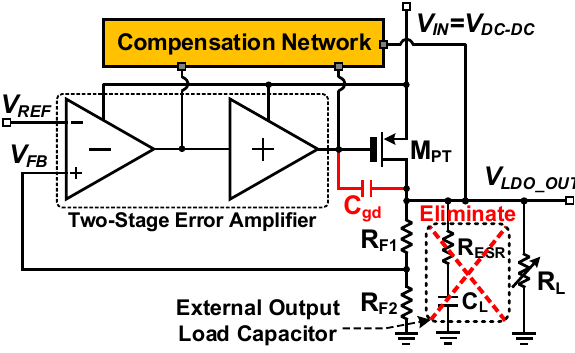
Figure 2. Output capacitor-less LDO (OCL-LDO) regulator with the compensation network.